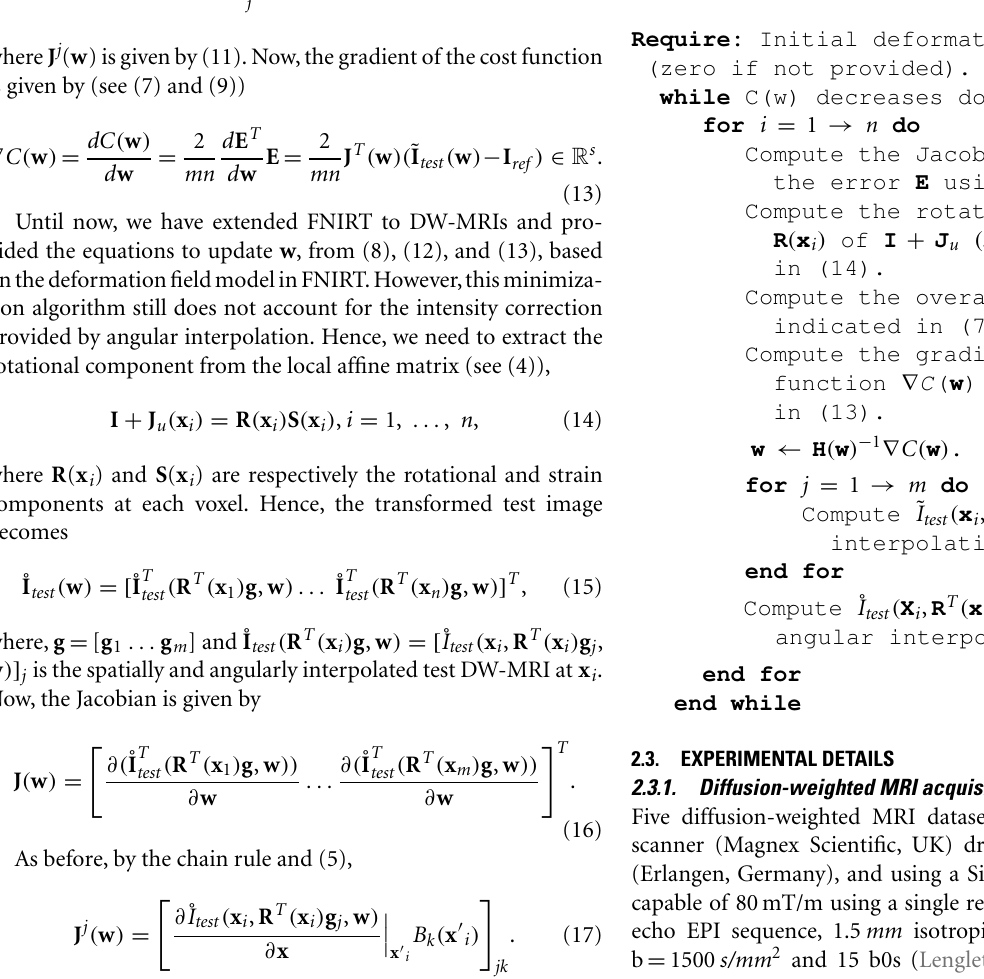
Algorithm 1. Non-linear Registration with Angular